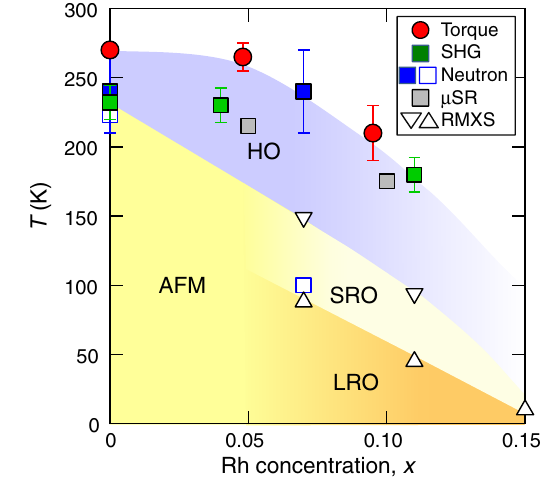
Þ O Rh 4 determined by x x